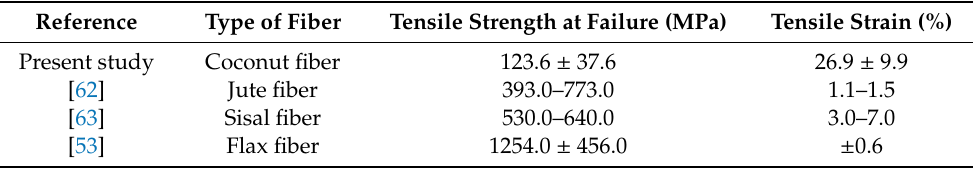
Table 5. Tensile properties of some plant